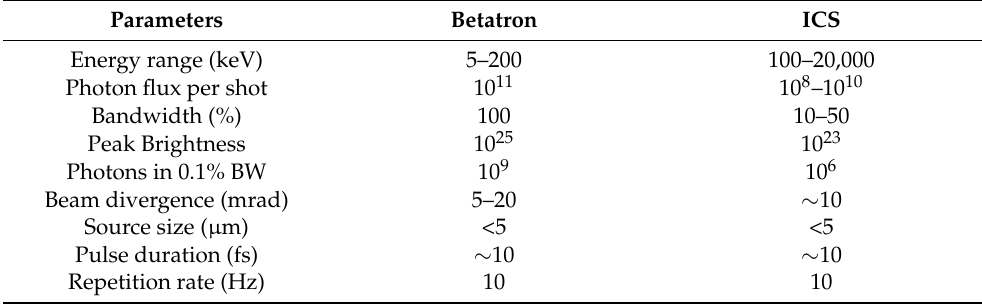
Table 2. Summary of X-ray source parameters expected at the Gammatron beamline, ELI Beam- lines